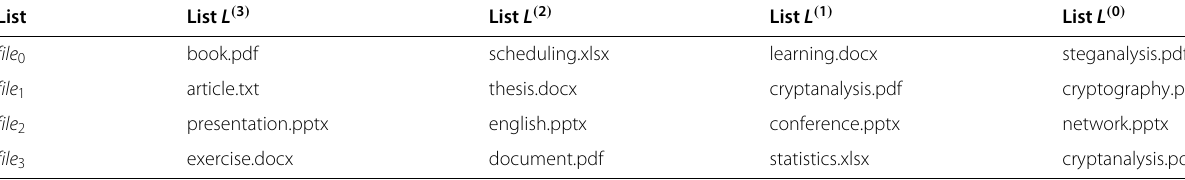
Table 5 Set of files distributed by list held by the